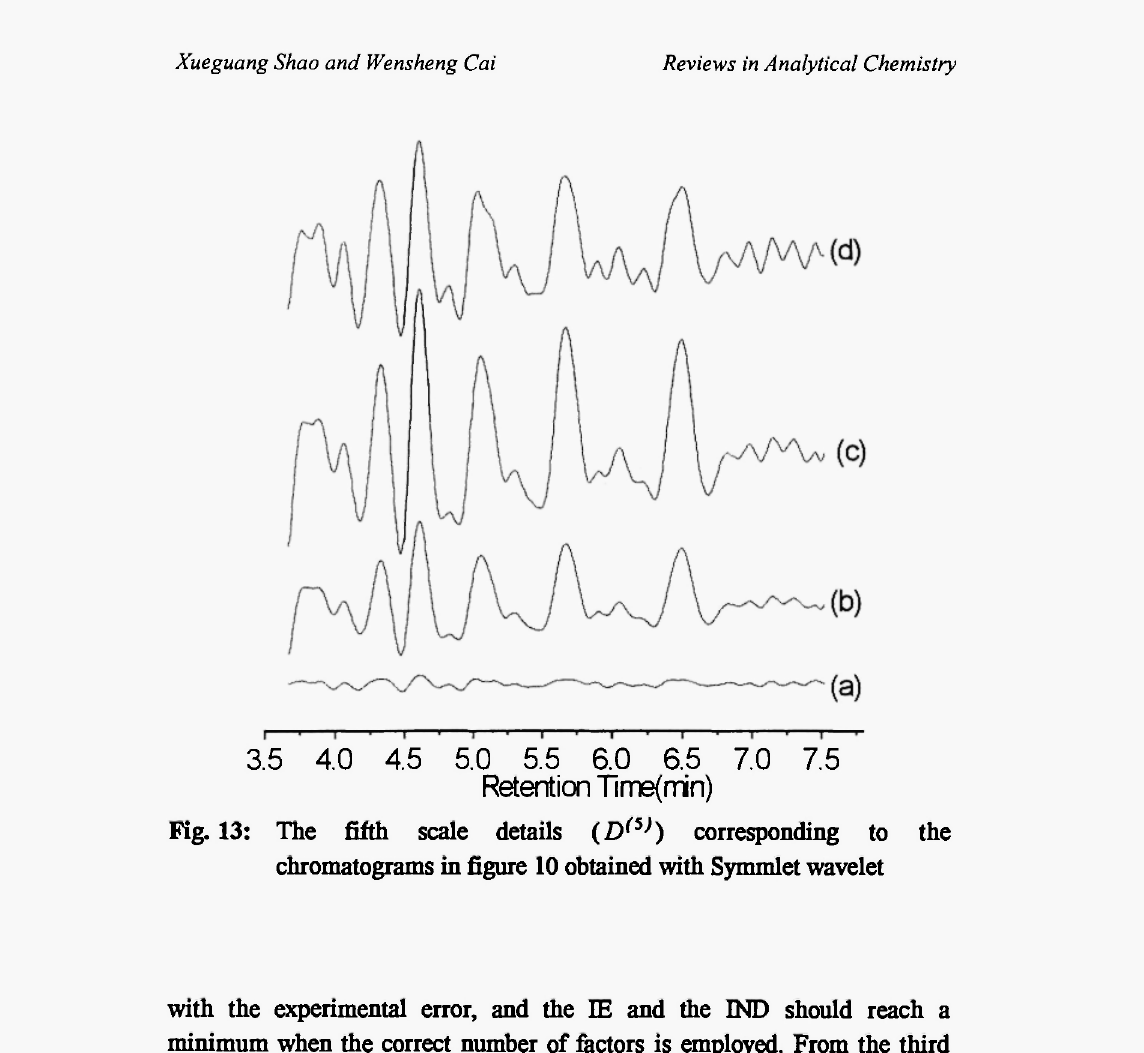
with the experimental error, and the IE and the IND should reach a minimum when the correct number of factors is employed. From the third column in Table 1, RSD reaches 10" 5 , which is the level of the experimental error, when n=12. This indicates that the factor number should be 12. But, from the results of the IE and the IND, the fourth and the fifth column in Table 1, they reach a minimum when n=ll and n=7, respectively.